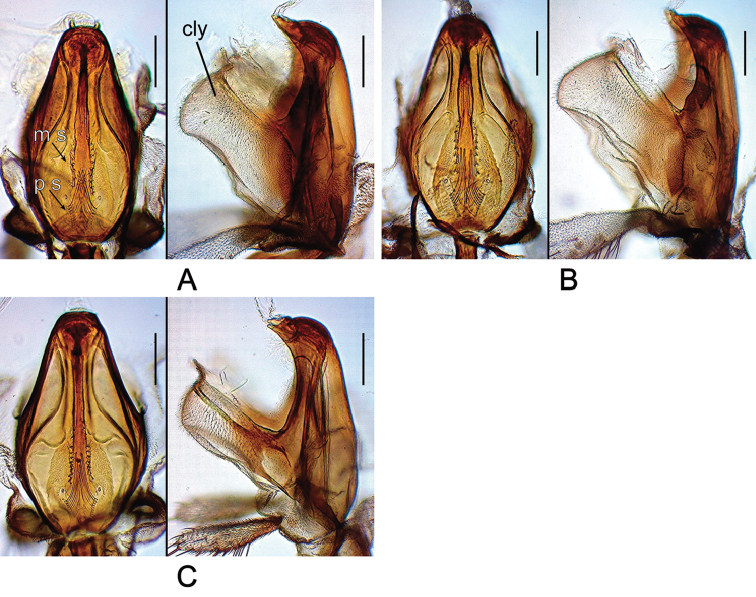
Cibarium of Dudaica species (part 2). Aqiongzhouensis sp. n. (paratype #03313) Borthophallata sp. n. (paratype #03905) Cdissimilis (holotype #00430). Scale bars: 0.1 mm.